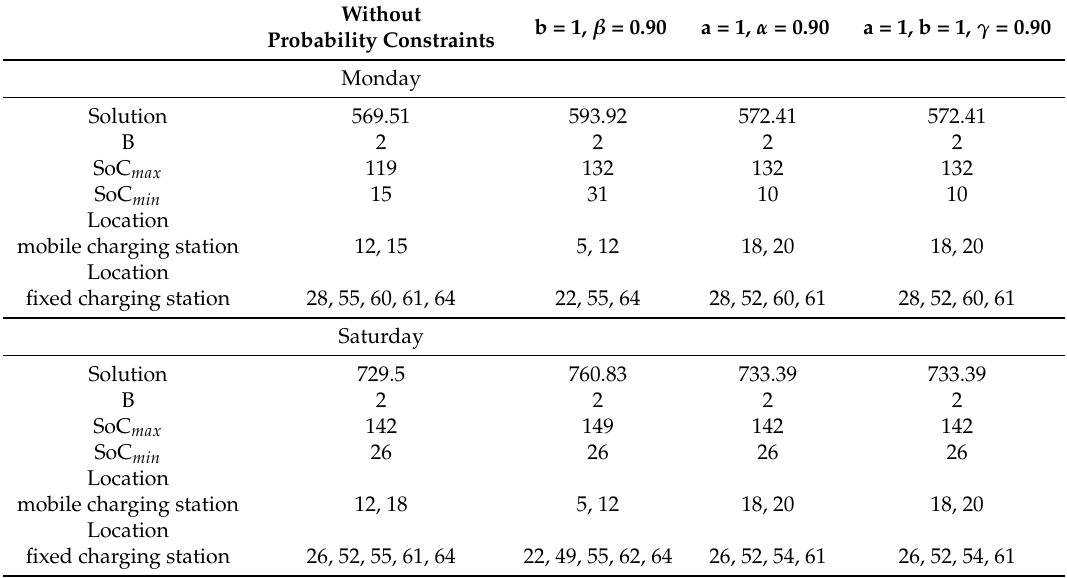
Table 3. Results for different days for ω U = 150 and 9:00–11:00 time period. Without